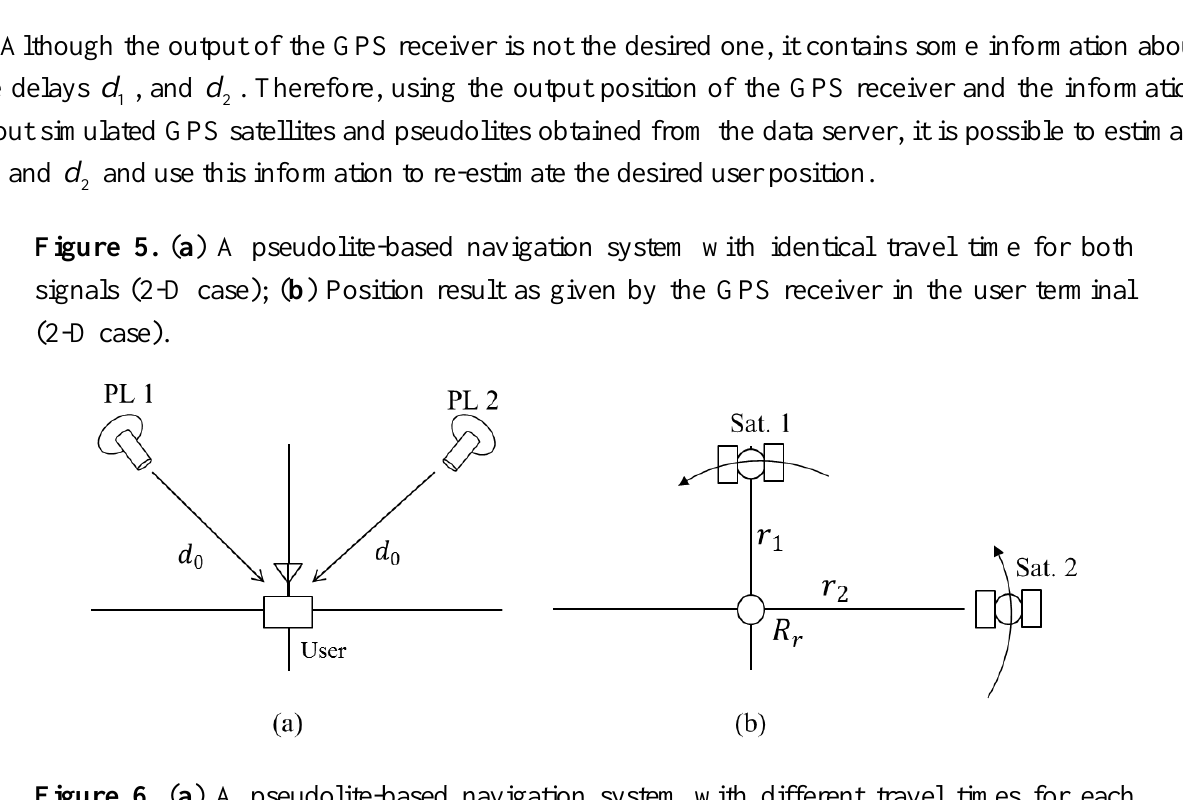
signal (2-D case); ( b ) Position result given by a GPS receiver in the user terminal (2-D